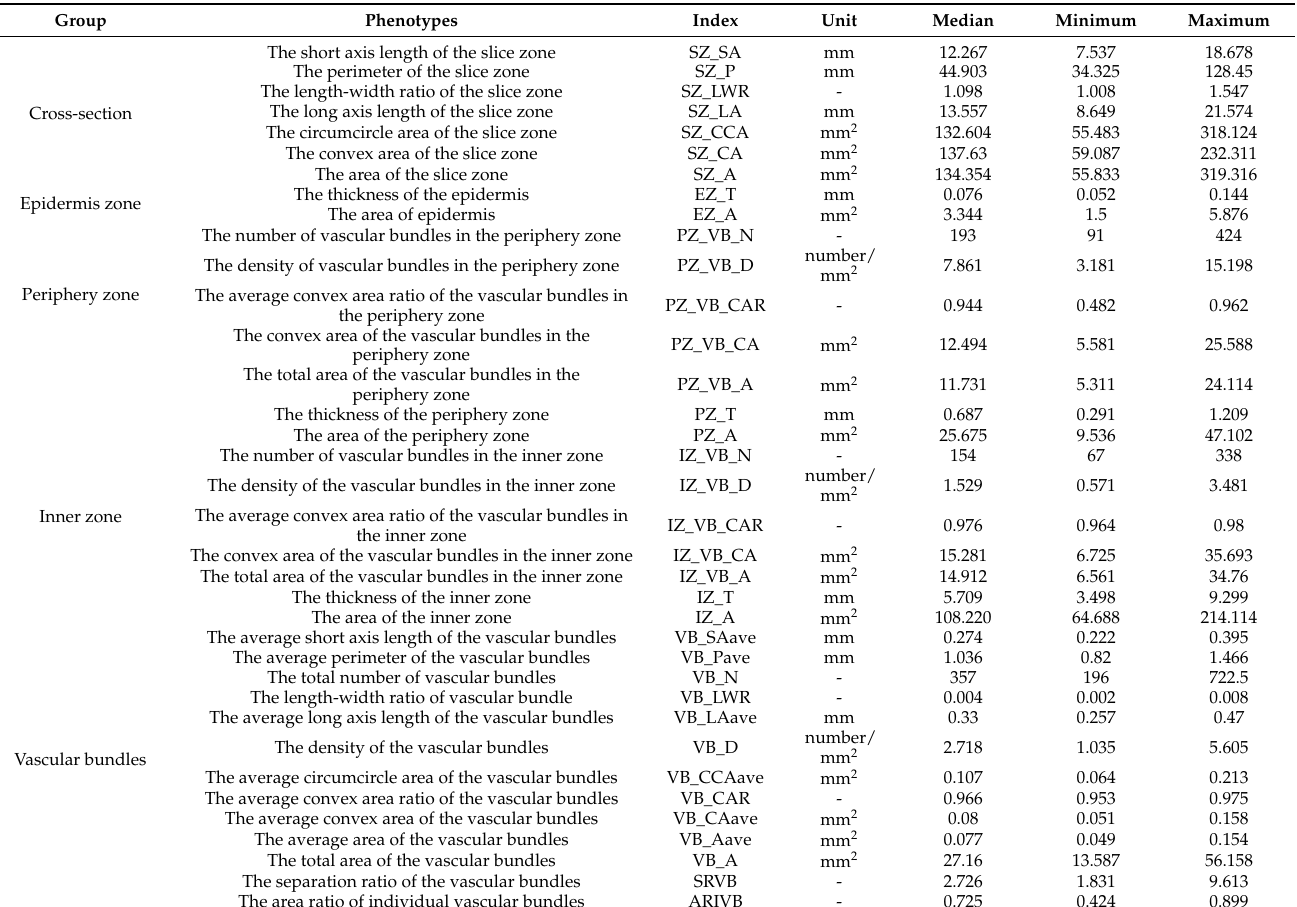
Table 1. The phenotypic variations in the vascular bundles at the base internode of the shank among a group of 202 inbred